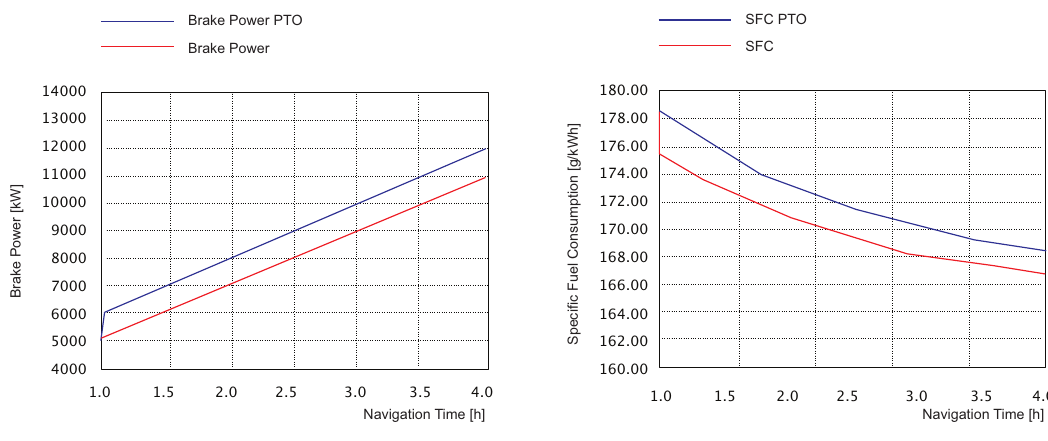
Figure 7. PTO evaluation